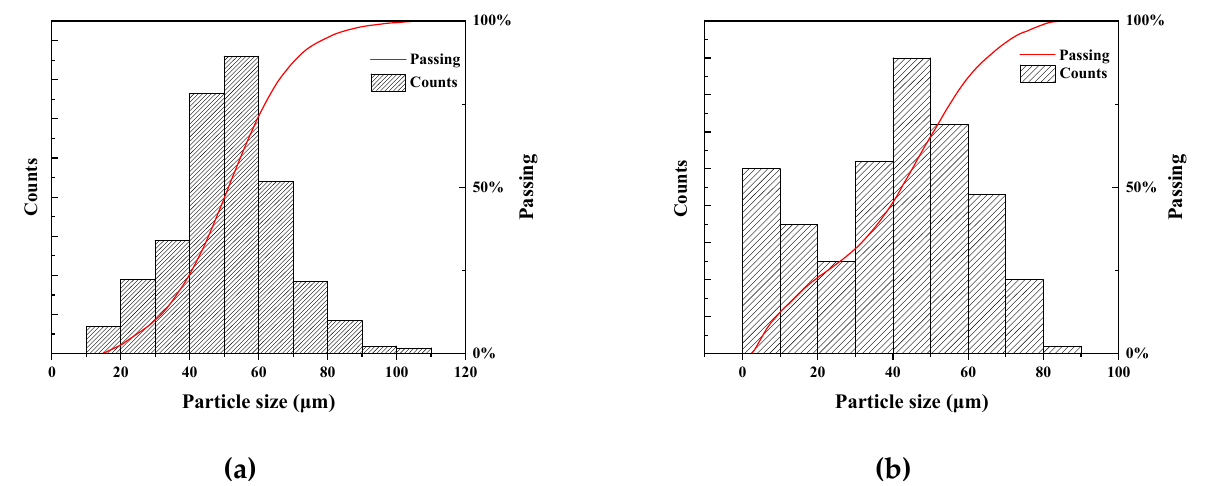
Figure 2. Particle distribution of steel slag before and after reconstruction. ( a ) Original BOF slag; ( b ) Reconstructed BOF slag. Table 3. SSA of original steel slag powder and reconstructed steel slag powder. Sample SSA (m 2 /kg) OS 303.1 RS